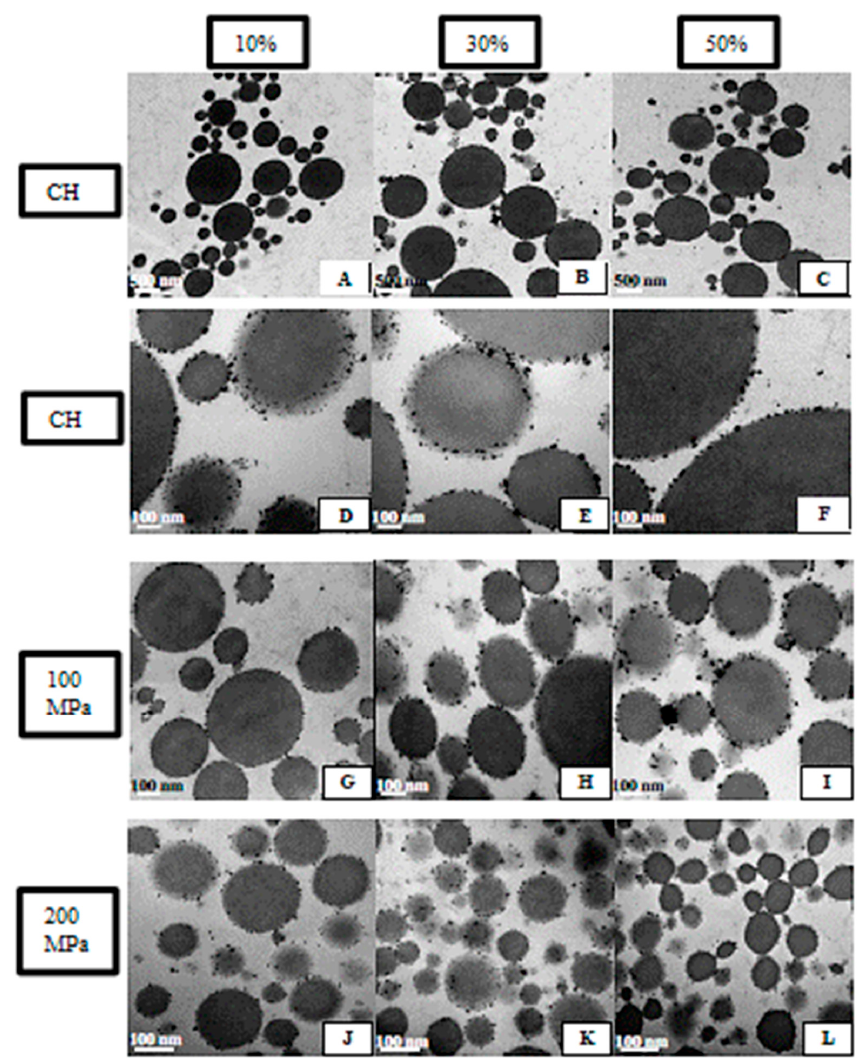
Figure 2. TEM images of emulsions containing 10%, 30% and 50% oil and WPI 4% stabilized by CH at 15 MPa ( A – C ) ×100,000 and ( D – F ) ×25,000 and by UHPH ×100,000 at 100 MPa ( G – I ) and 200 MPa ( J – L ), respectively. ( J – L ),